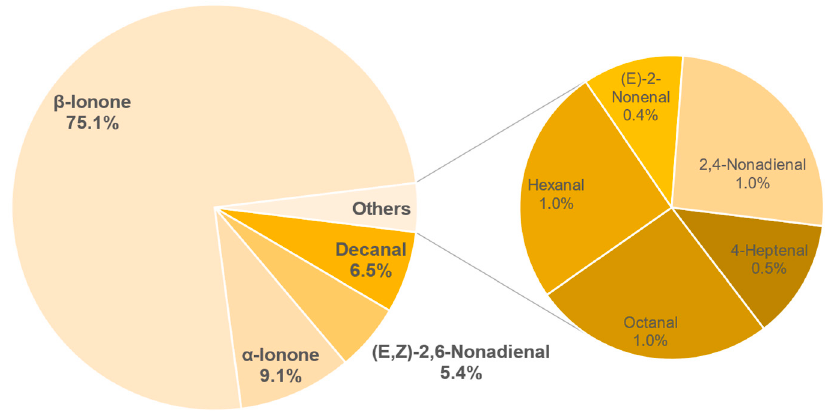
Figure 19. Percentage of OAV of each compound in the total aroma of sample 743.